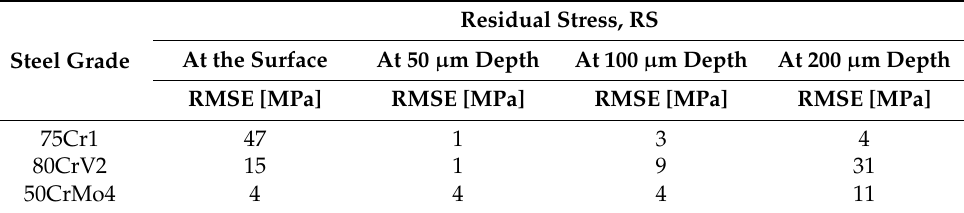
Table 8. Steel grades and results of verification measurements for residual stress.